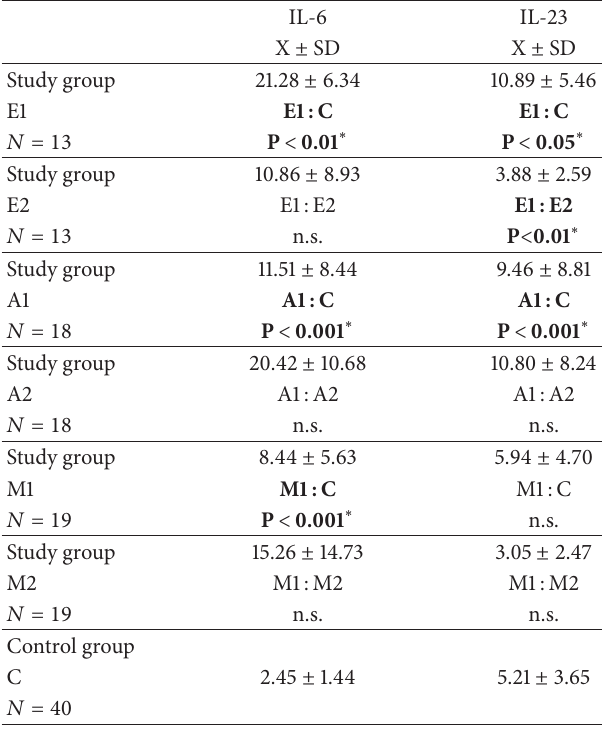
Table 3: The concentration of IL-6 and IL-23 in patients suffering from gastric cancer—early gastric cancer, E (E1 before surgery, E2 after surgery), advanced cancer with metastasis to lymph nodes, A (A1 before surgery, A2 after surgery), and metastatic tumor, M (M1 before surgery, M2 after surgery) and in normal donors